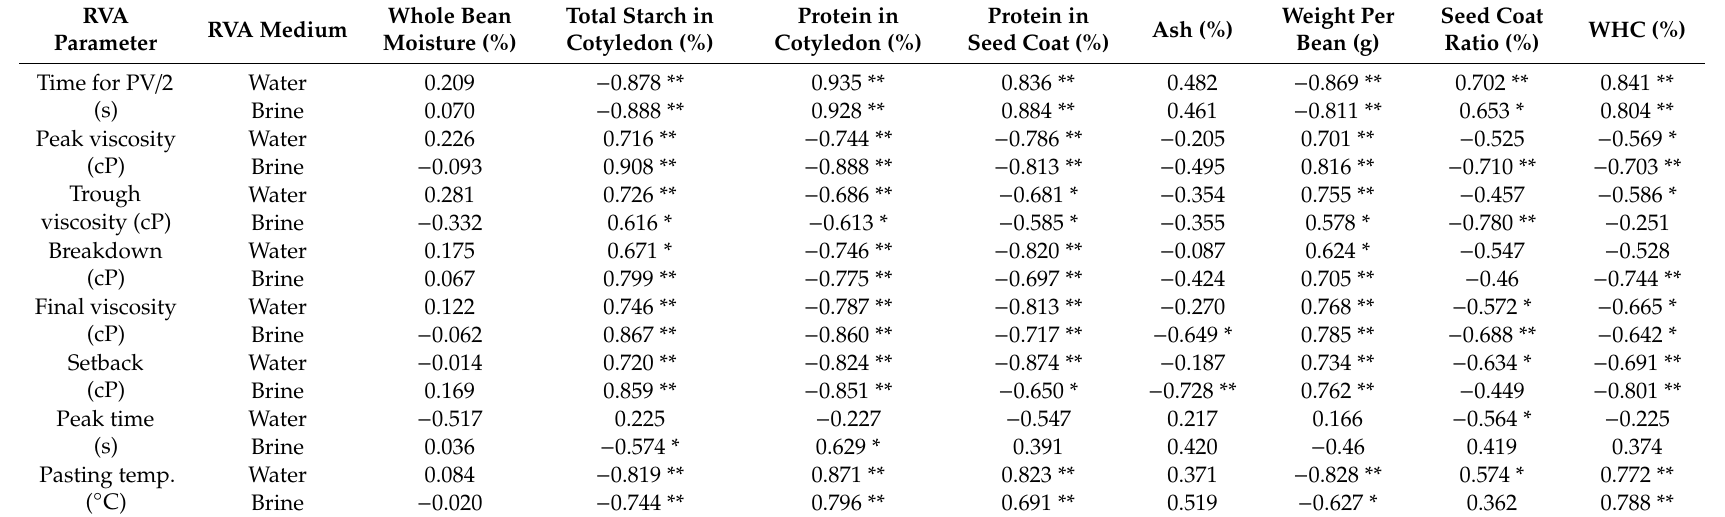
Table 6. Pearson’s correlation between pasting properties of bean flours and compositional and physical properties of the dry beans